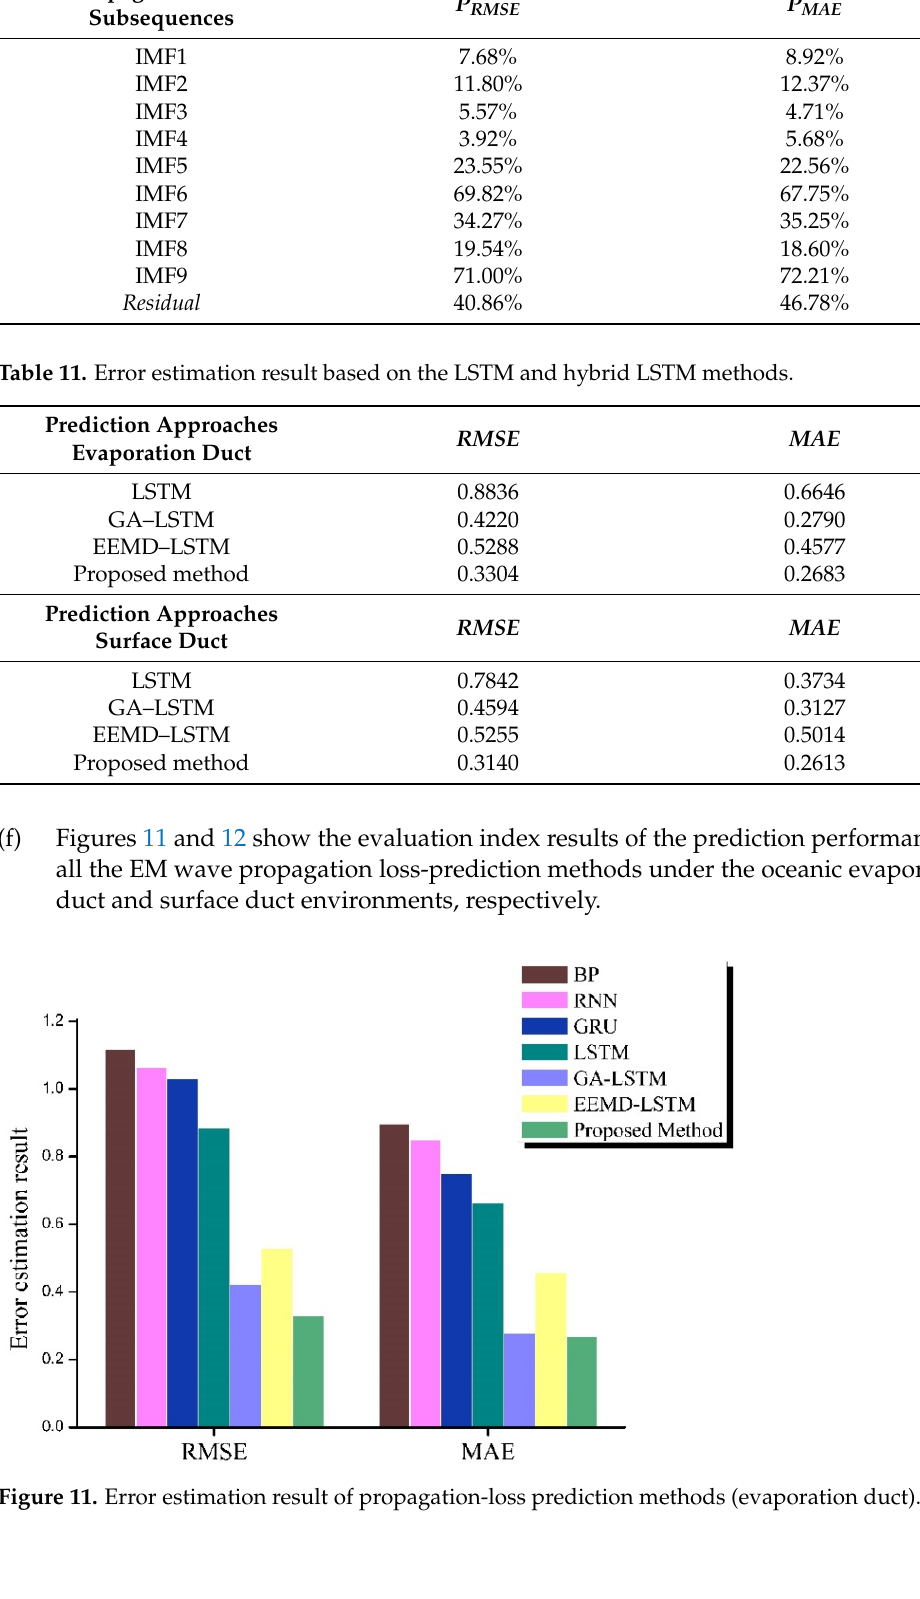
Figure 12. Error estimation result of propagation-loss prediction methods (surface duct). 4.2. Field Data Testing To further test the predictive performance of the proposed method in the actual oce- anic duct environment, real field data was used. True doppler weather radar echoes power observation data from the observation at Qingdao Meteorological Bureau ( 120